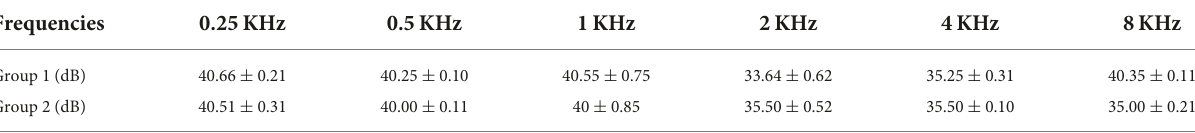
TABLE 3 The average preoperative BC in patients with type II labyrinthine fistulas in group 1 and 2. Frequencies